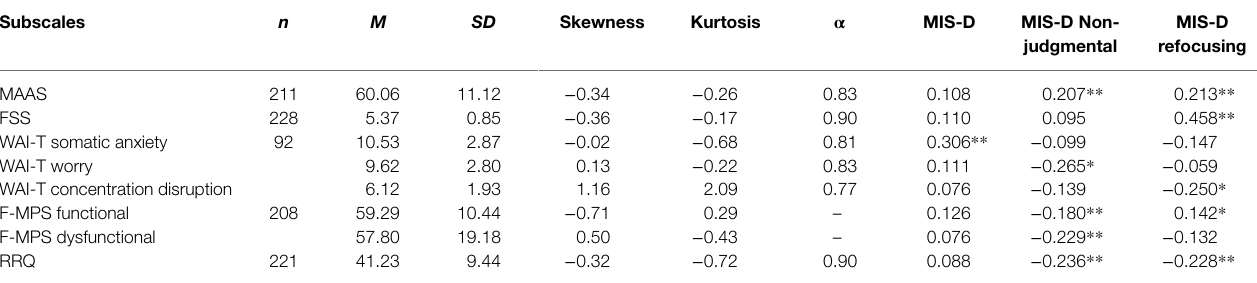
TABLE 3 | Bivariate correlations (Bravais–Pearson correlation) between the MIS-D (German translation) and the subscales of five conceptually related constructs. Subscales n M SD Skewness Kurtosis α MIS-D MIS-D Non-